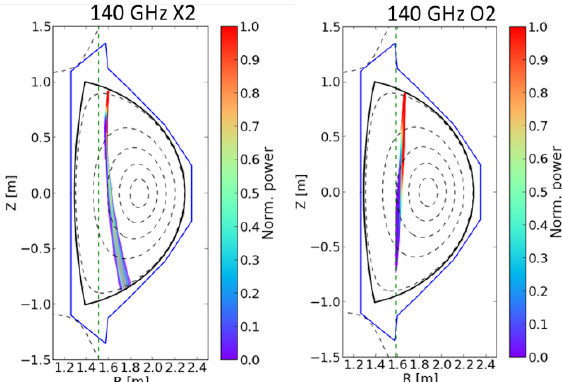
Fig. 7. Comparison of second harmonic up-shift vertical top launch of 140 GHz X2 and O2 waves for n e (0) = 7 x 10 19 m -3 and T e (0) = 7 keV.